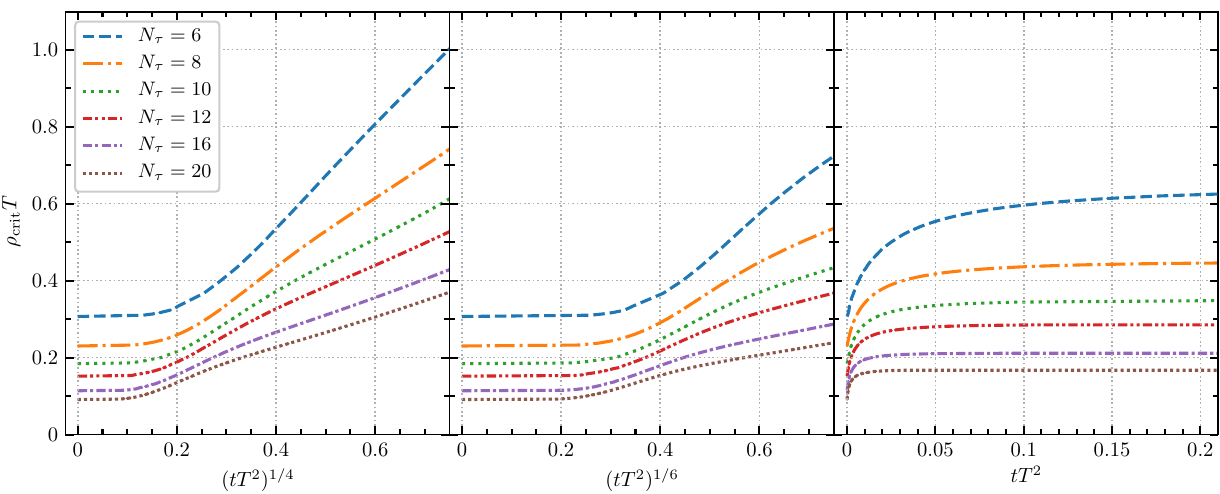
Fig. 4 Critical caloron radius (separating calorons which survive from those which collapse) as a function of flow depth for three types of flow, and several different temporal lattice extents. Left: Wilson flow. Middle: Zeuthen flow. Right: Overimproved